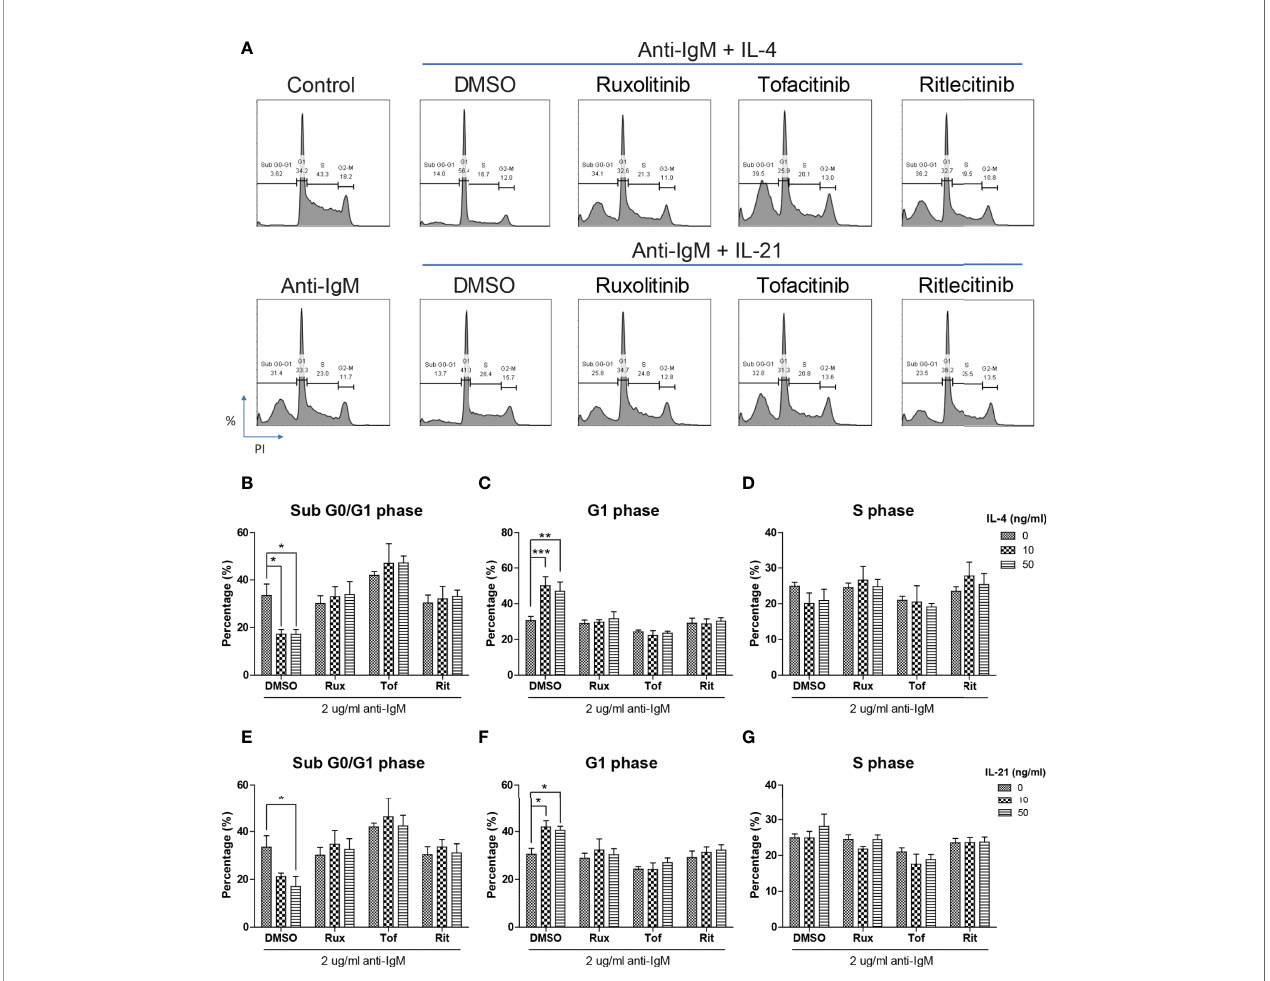
FIGURE 7 | JAK inhibitors attenuated IL-4 and IL-21 rescues of cell cycle arrest and DNA damage. (A) Representative images showed that all JAK inhibitors suppressed IL-4 and IL-21 effects in repairment of DNA damage and cell cycle reentry. (B-D) Quanti fi cation showed that application of three JAK inhibitors suppressed IL-4 driven escape from sub G0/G1 and maintenance in G1 phase in Ramos cells. (E-G) Statistical analyses also demonstrated that all JAK inhibitors suppressed IL-21 driven escape from sub G0/G1 and cell cycle reentry in Ramos cells. All groups shown in the fi gures were treated with 2 µg/ml anti-IgM for 48 hours. ***p < 0.001, **p < 0.01, *p < 0.05 as compared to indicated DMSO control group by two-way ANOVA, N =